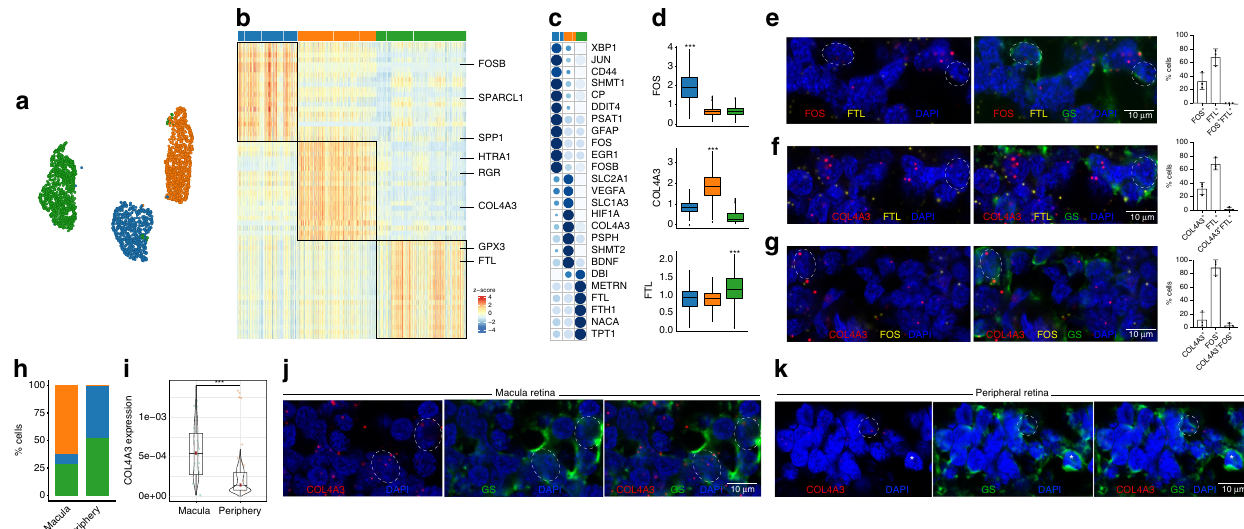
Fig. 3 Heterogeneity within Müller glia and astrocytes in the human retina. a Cell-to-cell similarity network (ACTIONet) representation of the fi ltered set of Müller glia and astrocytes, highlighting three major subtypes. b Scaled heatmap of top differentially expressed genes within different cell groups. c Dot plot showing the row-normalized ( z -score) mean expression of the top-ranked genes across subtypes of macroglial cells. d Imputed expression of key marker genes, normalized by the average of their expression across all macroglial cells. *** p < 0.001, one-sided Wilcoxon rank-sum test. Box plots are centered around the median, with the interquartile range (IQR) de fi ning the box. The upper whisker extends to the largest value and the lower whisker extends to the smallest value, no further than 1.5 × IQR from the end of the box. e – g Representative images of multiplex in situ hybridization of e FTL (labeled in yellow) and FOS (labeled in red), f FTL (labeled in yellow) and COL4A3 (labeled in red), and g FOS (labeled in yellow) and COL4A3 (labeled in red), with immuno fl uorescence of glutamine synthetase (GS, identi fi ed in green). Bar graphs showing frequencies of e FOS + , FTL + , or FOS + FTL + GS + macroglia in the macula retina, f COL4A3 + , FTL + , or COL4A3 + FTL + GS + macroglia in the macula retina, and g COL4A3 + , FOS + , or COL4A3 + FOS + GS + macroglia in the peripheral retina. Error bars show standard error of mean. White circles indicate positive cells. Data are representative of three independent experiments. h Bar graph showing frequency of each subset within the macula vs. peripheral region of the retina. i Violin plot showing gene expression differences of COL4A3 between the macula and peripheral retina. Difference is statistically signi fi cant with p < 0.01, one-sided Wilcoxon rank-sum test. j – k Representative images of multiplex in situ hybridization of COL4A3 (labeled in red) with immuno fl uorescence of glutamine synthetase (GS, identi fi ed in green) in the j macula, and k peripheral retina. White circles indicate COL4A3 + cells, and white asterisk indicates COL4A3 − cells. Data is representative